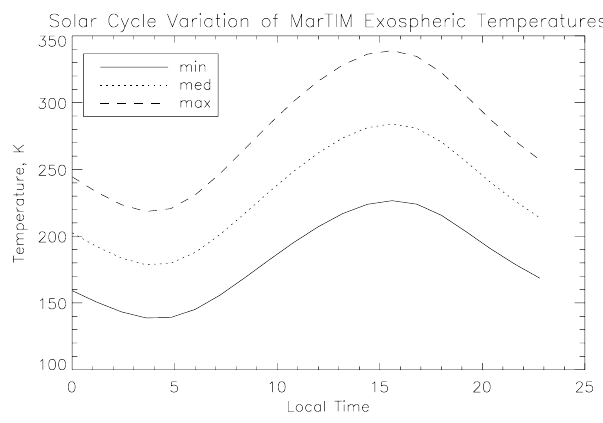
Fig. 1. Thermospheric (pressure=2.7 × 10 − 7 Pa) temperature varia- tion, from MarTIM, L s =0 ◦ , for solar minimum, medium and max- imum conditions, along the equator over a